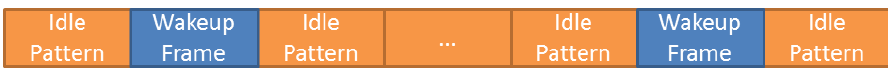
Figure 14. Complete frame format of VLC communication. Figure 13. Intra-frame flickering compensation. ( a ) Signal without dimming; ( b ) Signal with dimming applied to the logic zero bits.